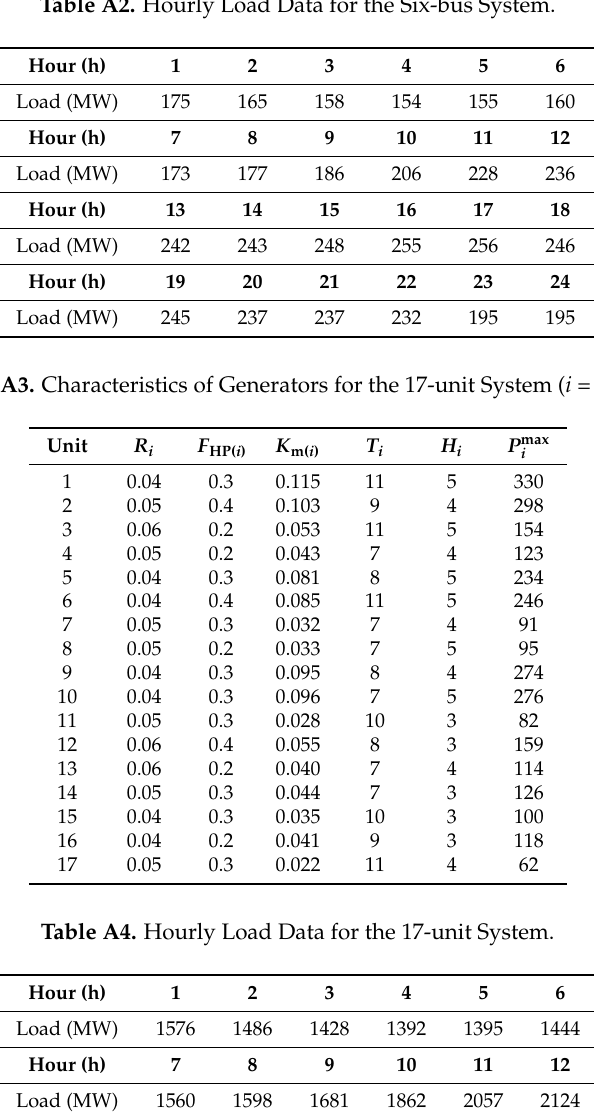
Table A2. Hourly Load Data for the Six-bus System.